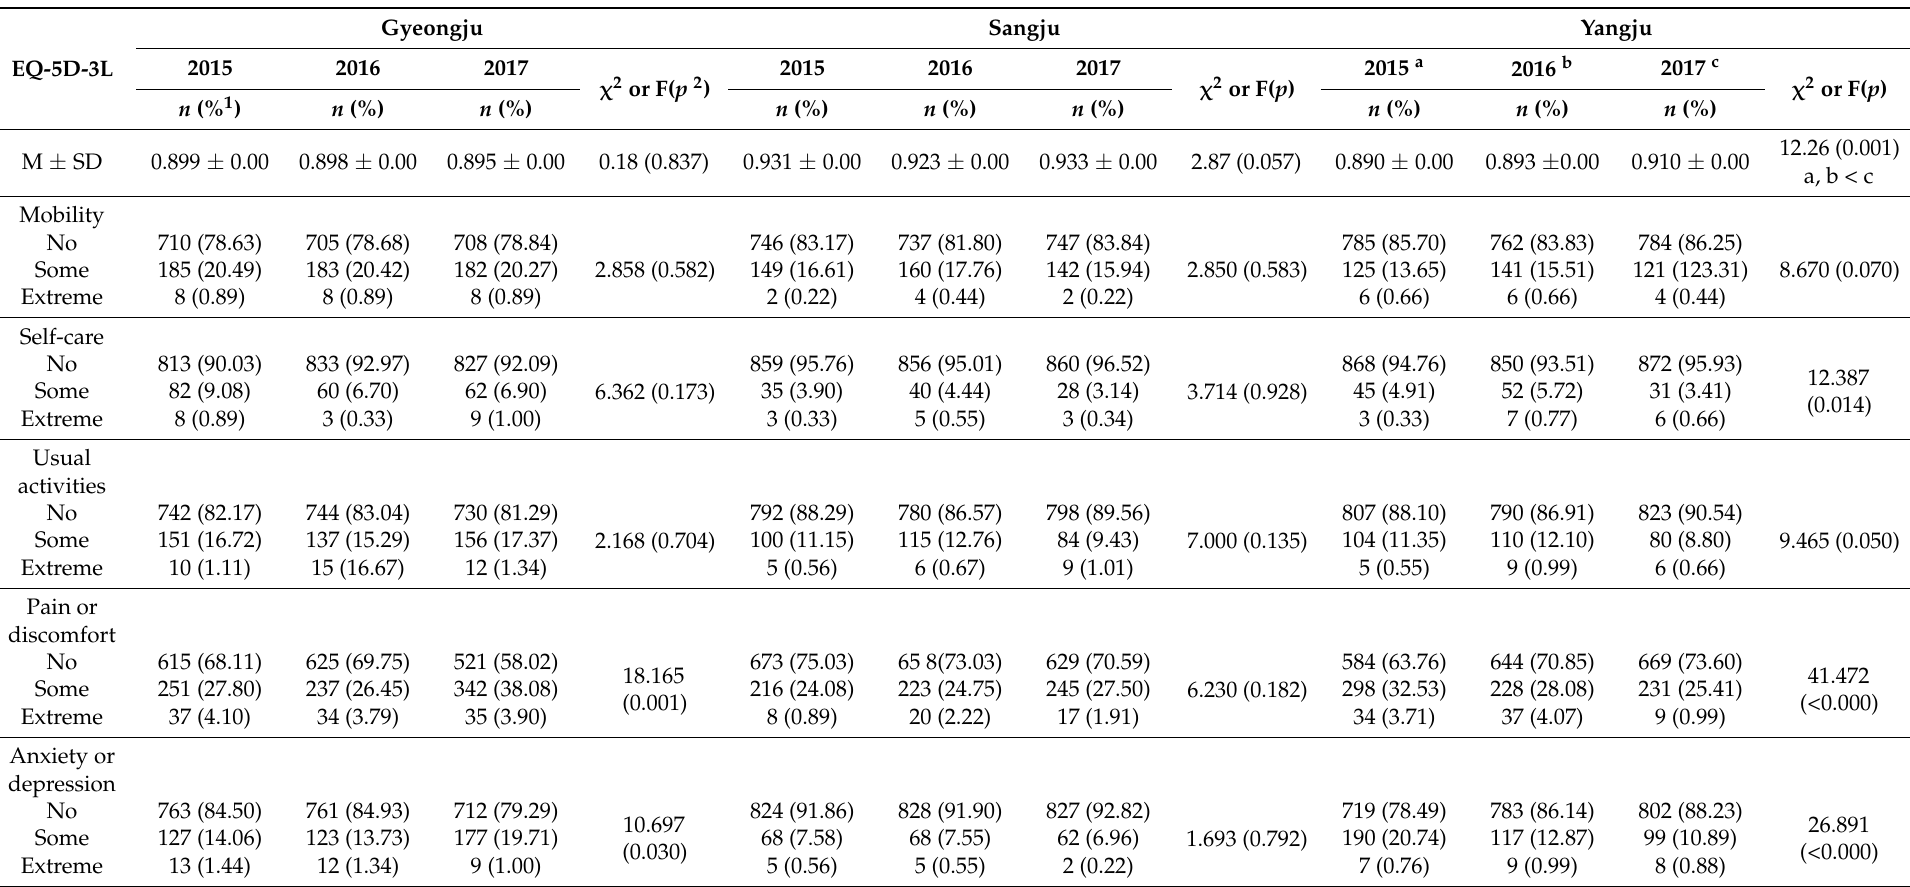
Table 4. The differences in health-related quality of life by years in each region ( n =